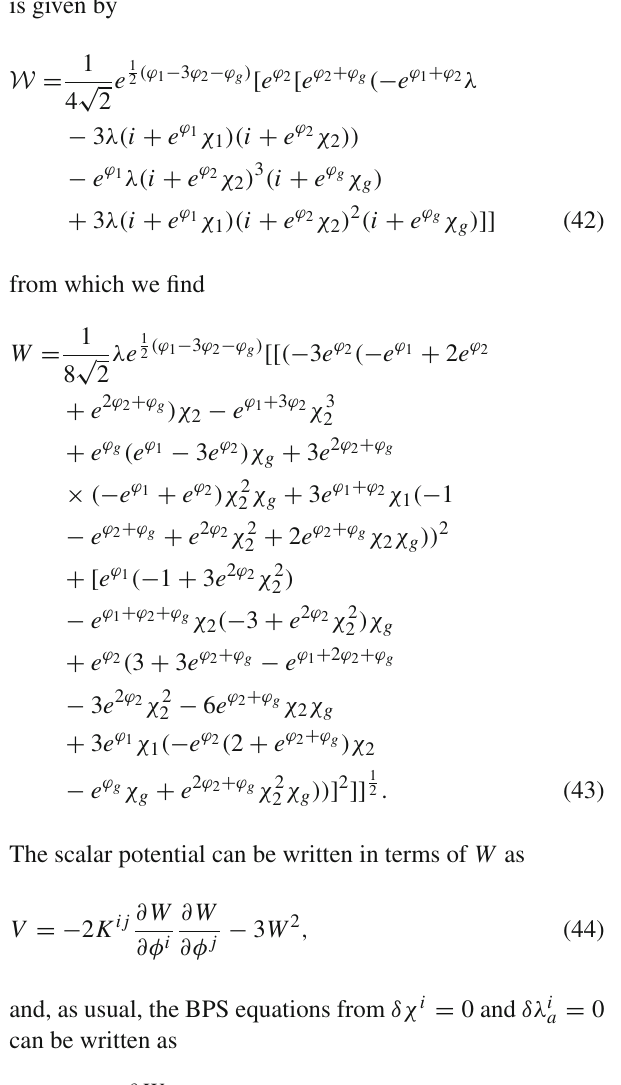
Table 1 Scalar masses at the N = 4 supersymmetric AdS 4 critical point with SO ( 3 ) × SO ( 3 ) symmetry and the corresponding dimensions of the dual operators